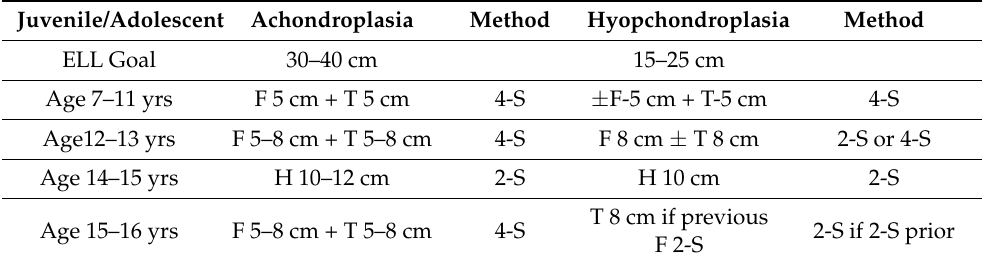
Table 4. ELL age and lengthening goal algorithm for Achondroplasia and